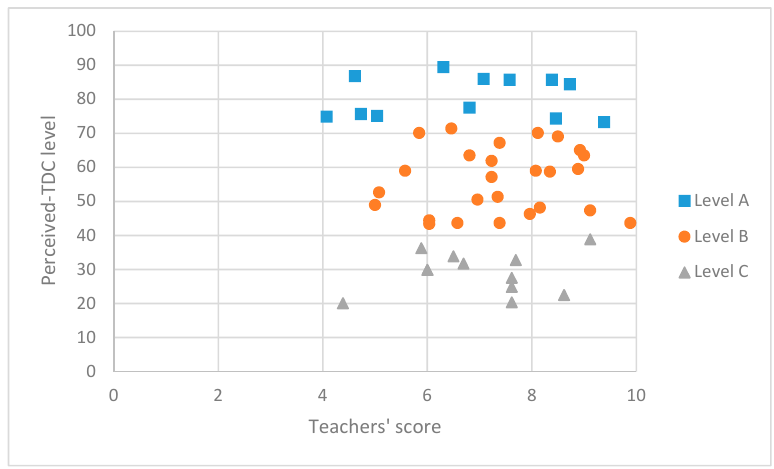
Figure 3. The teachers’ scores in the video preparation training course were plotted against their perceived ‐ TDC level. Grades were sorted according to TDC: squares for Level C (>72%), circles for Level B (43–72%), and triangle for Level A (<43%).